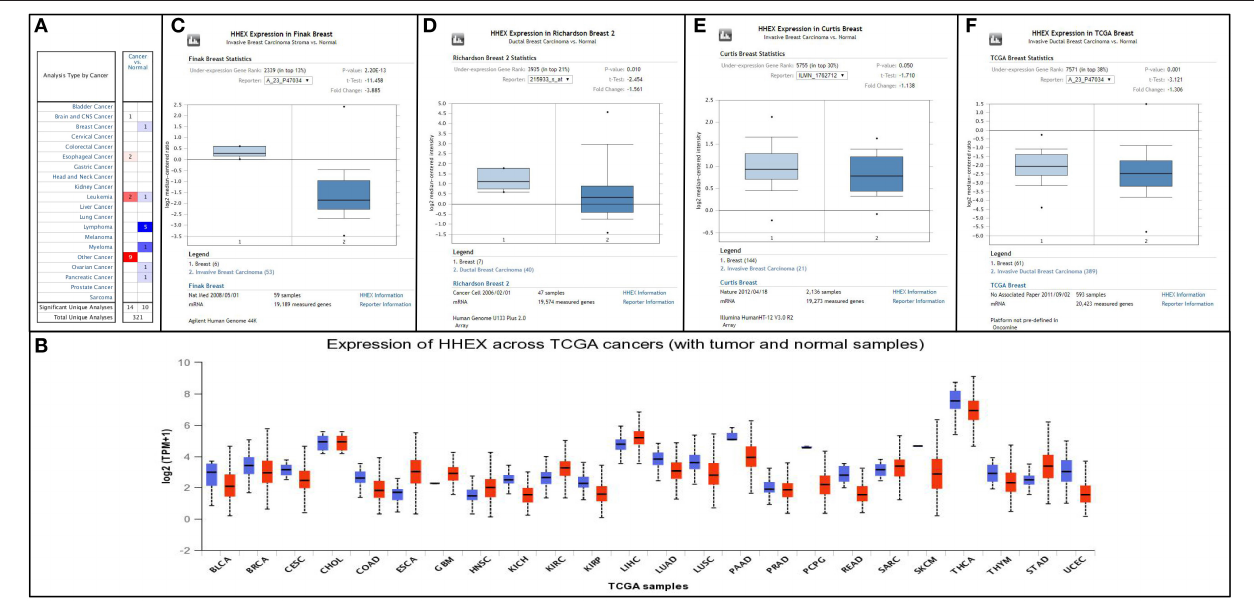
FIGURE 1 | Expression levels of HHEX in pan-cancers and breast cancer (BC) patients. (A,B) Transcriptional levels of HHEX in different types of cancers determined using the Oncomine and UALCAN databases. Cell color was determined using the best gene rank percentile for the analyses within the cell, and the gene rank was analyzed using percentile of the target gene in the top of all genes measured in each study. (C–F) mRNA levels of HHEX in BC determined using